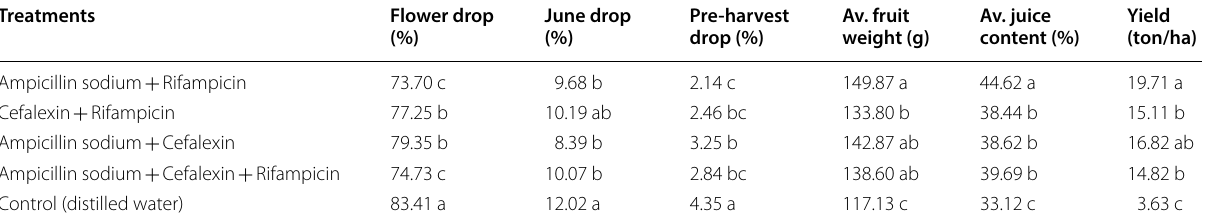
Table 4 Flower and fruit drops (%) and fruit physical characteristics as affected by different antibiotic treatments